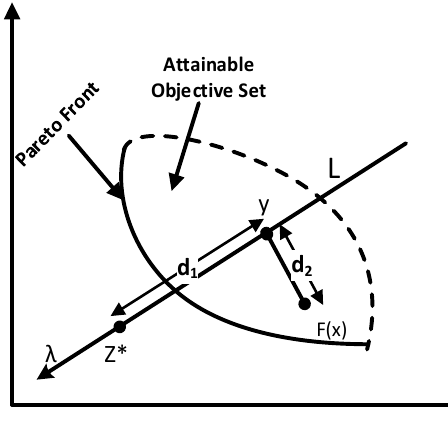
Figure 1. Penalty-based Boundary Intersection